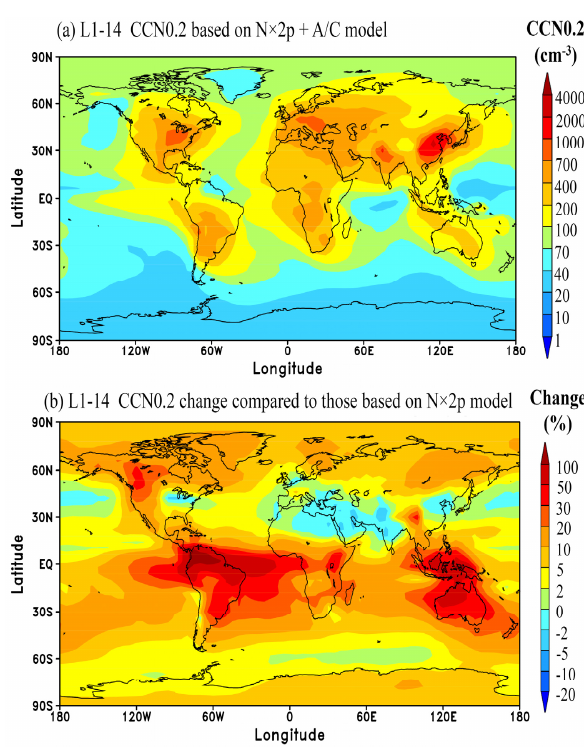
Figure 10. Fig. 10. (a) Horizontal distributions of annual mean number con- centrations of cloud condensation nuclei at a water supersaturation ratio of 0.2% (CCN0.2) in the lower troposphere (0–2km above sur- face) simulated with the N × 2p+A/C new SOA formation model described in this paper. (b) Percentage change in CCN0.2 compared to the case without oxidation aging and LV-SOG condensation (i.e., original N × 2p